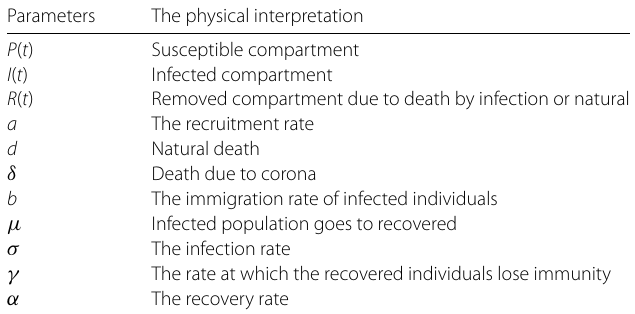
Table 1 Illustration of the parameters involved in model